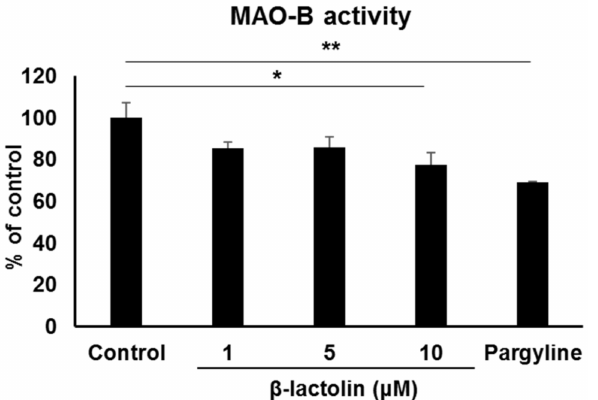
Figure 2. The effect of β -lactolin on MAO-B activity in astrocyte mitochondria. Cells were treated with 0, 1, 5, or 10 µ M β -lactolin or 10 µ M pargyline for 5 h. MAO activity assay was performed on mitochondria isolated from astrocytes. Pargyline, a selective MAO inhibitor, was used as a positive control. Data represent the mean ± SEM ( n = 3). The p values were calculated using one-way ANOVA followed by Dunnett’s multiple comparison test. * p < 0.05, ** p < 0.01. MAO-B, monoamine oxidase B; ANOVA, analysis of variance; SEM, standard error of the